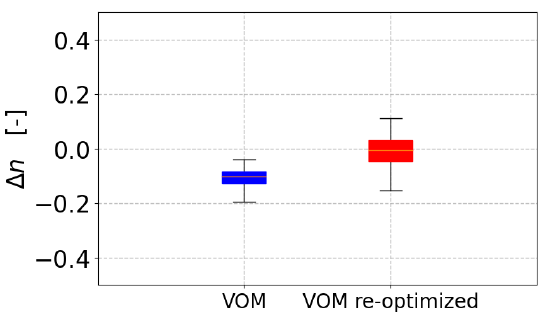
Figure 10. Changes in n in response to a 20% increase in pre- cipitation ( P ). VOM simulations are shown in for 36 sites along the NATT, with the blue box (left) representing VOM simulations where the long-term vegetation properties were not re-optimized to the increased P and the red box (right) representing simulations where all vegetation properties were re-optimized for the increased P . The n values were obtained by fitting Eq. (3) to each individual site for a given P